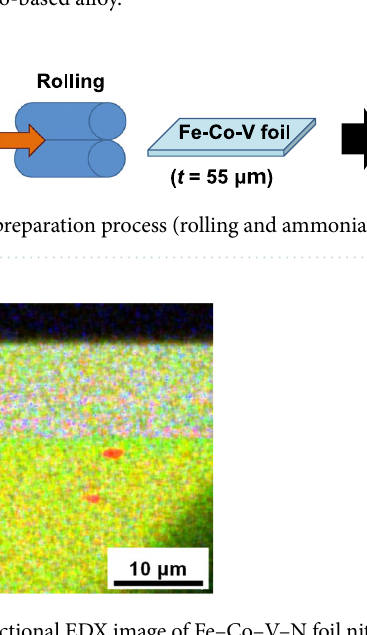
Figure 3. Cross-sectional EDX image of Fe–Co–V–N foil nitrided at T = 650